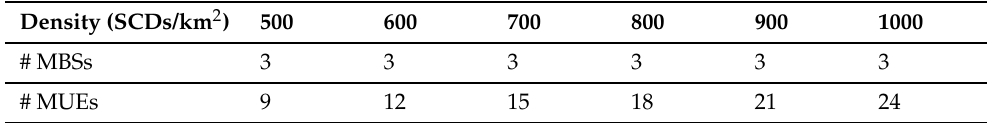
Table 5. The different network size scenarios.